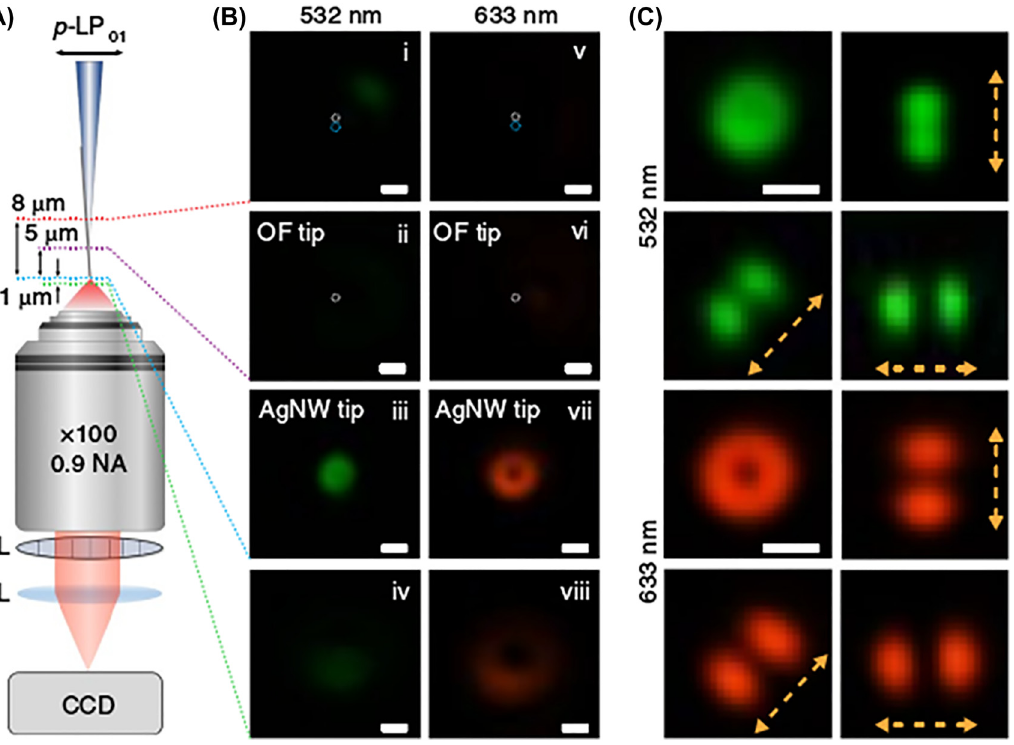
mode excitation and nanofocusing. Figure 7: Experimental verification of TM 0 (A) Sketch map of high-magnification optical microscope for characterizing converter process of linear fiber mode (LP ). PL: polarization analyzer; L: lens; CCD: charge coupled device. (B) Images of different focal plane located along the hybrid fiber tip: (TM 0 near the coupling zones (i, v); at apex of the optical fiber taper (ii, vi); at apex of the Ag nanowire tip (iii, vii); defocused by 1 μ m (iv, viii). Excitation wavelengths are 532 and 633 nm respectively. (C) Polarization examination results of B (iii) and (vii). Yellow dashed arrows illustrate the transmission axis of PL. Scale bars, 500 nm. Adapted from Ref. [92]. Copyright Kim S, Yu N, Ma XZ, Zhu Y, Liu Q, Liu M, Yan R, under exclusive licence to Springer Nature Limited